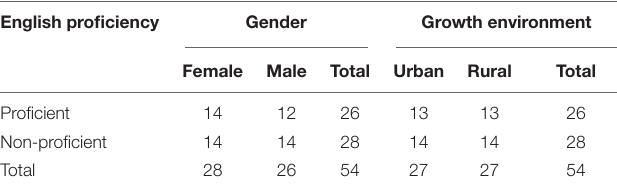
TABLE 3 | The number of participants on gender, growth environment, and English proficiency in experiment